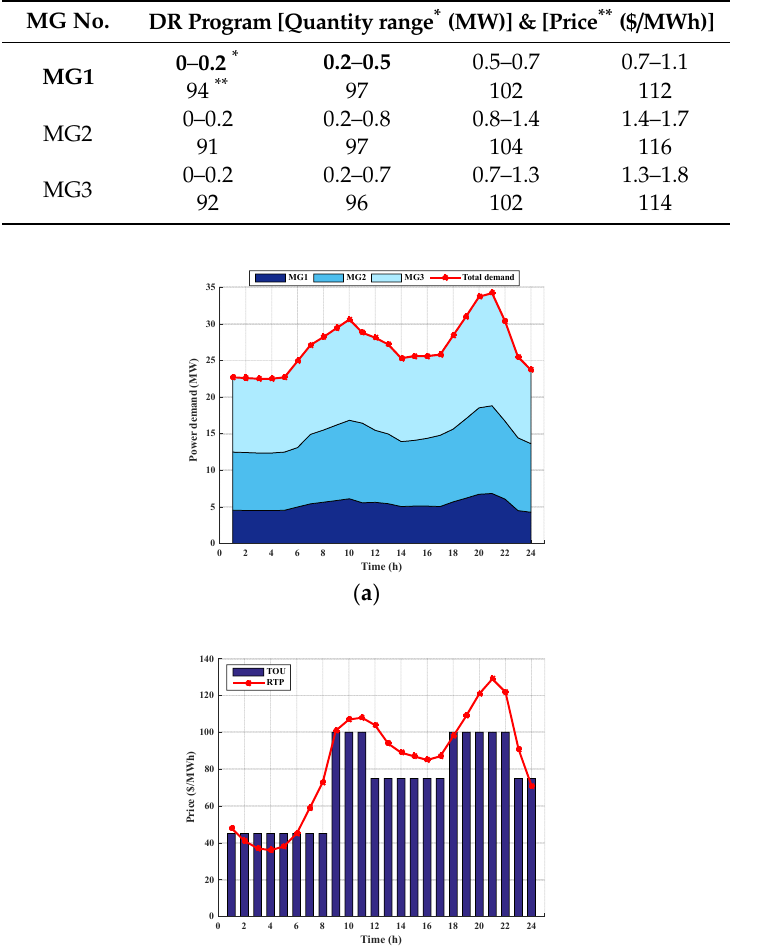
Table 4. Summary of the defined Case studies (CSs) and scenarios. Scenario 1